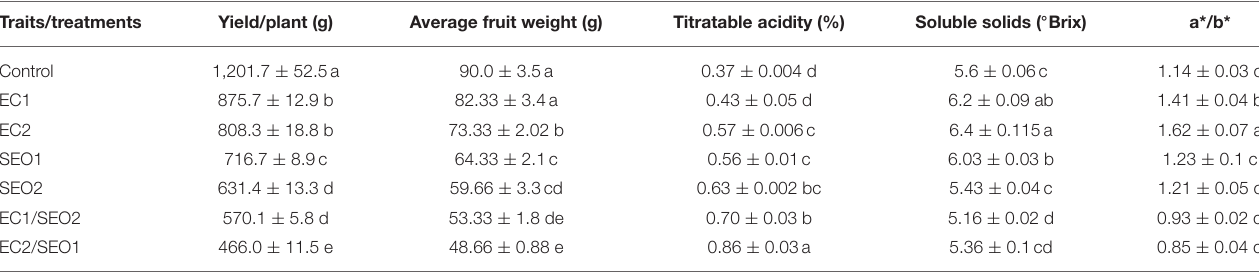
TABLE 1 | Main processing attributes (yield/plant, average fruit weight, titratable acidity, total soluble solids and a * /b * ratio) of red-ripe tomato fruits (cv. Rio Grande) harvested from plants subjected to control conditions (0.4 dS/m EC, no SEO), saline stress (EC1, 3.5 dS/m; EC2, 7 dS/m), spent engine oil stress (SEO1, 0.5%; SEO2, 1%), and saline/SEO combinations (EC1/SEO2, 3.5 dS/m/1% SEO; (EC2/SEO1, 7 dS/m/0.5% SEO).